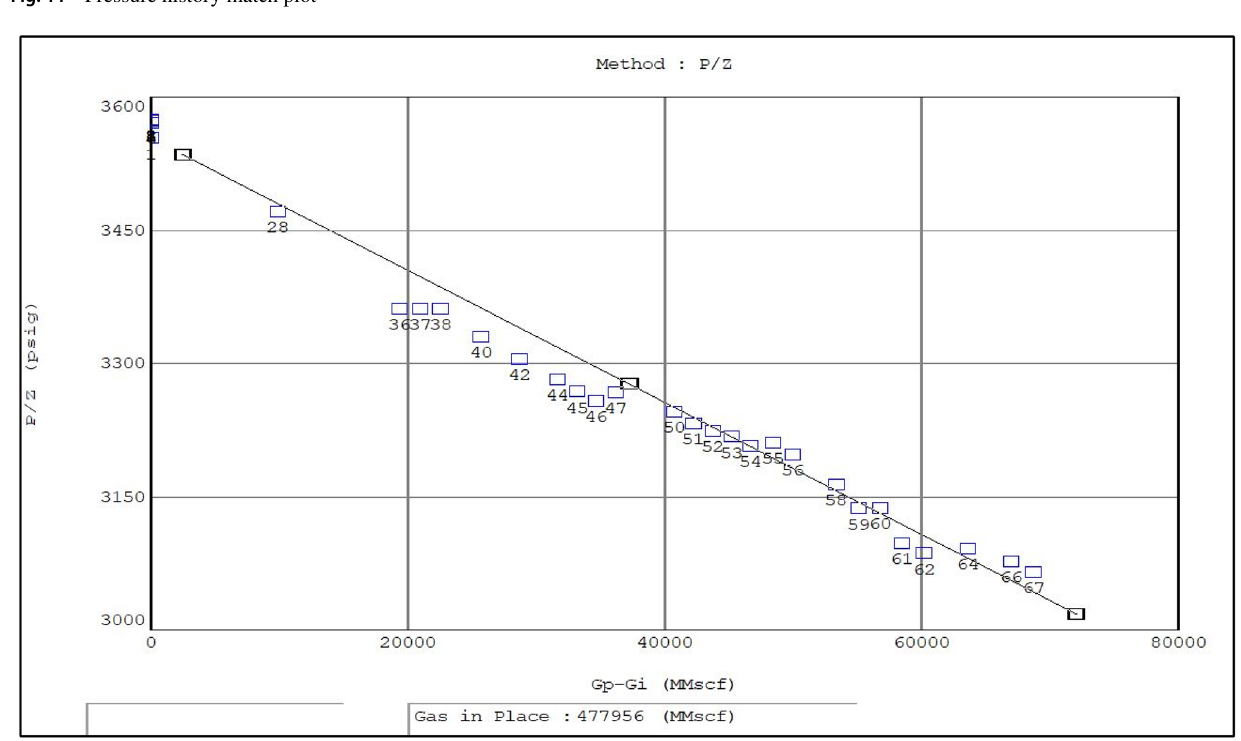
Fig. 12 Traditional P/Z